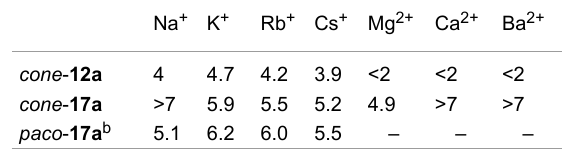
Table 2: Association constants (log K assoc ) of alkali- and alkaline- earth-metal complexes. a,b .